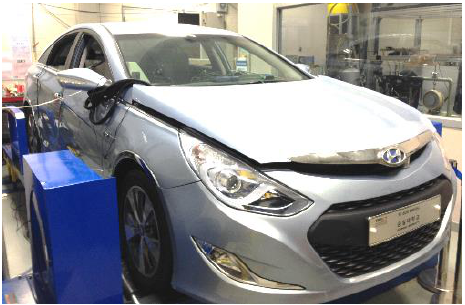
Figure 1. TMED type parallel hybrid vehicle and chassis dynamometer.